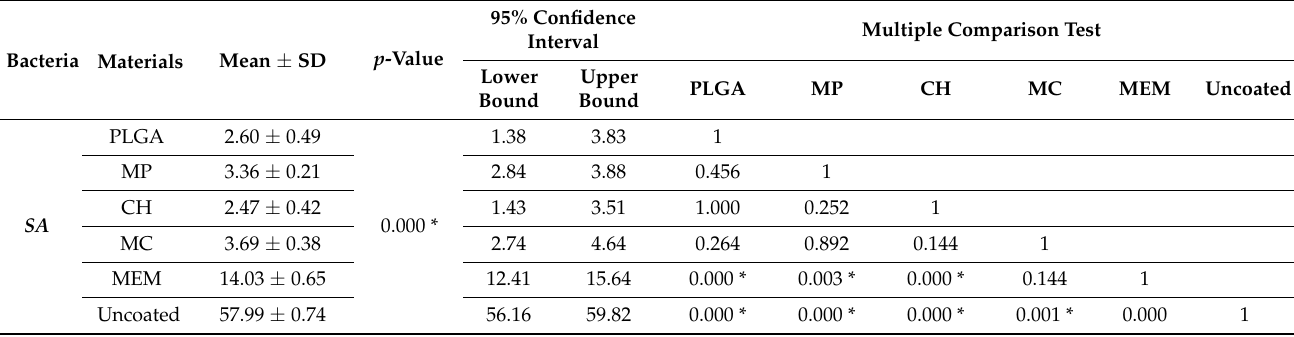
Table 2. MTT differences for SA and PA between